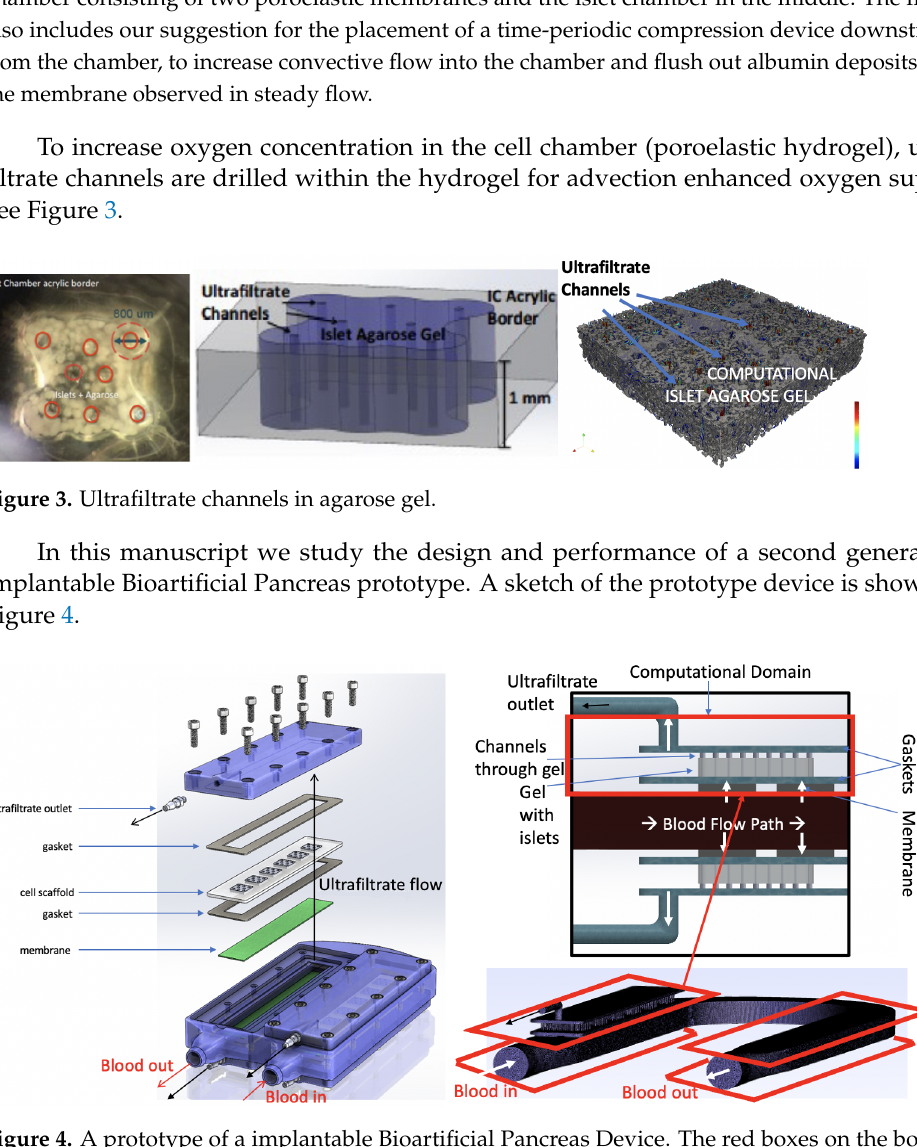
Figure 4. A prototype of a implantable Bioartificial Pancreas Device. The red boxes on the bottom right figure show the location where the four islet chambers are located. Only one of the four chambers is fully depicted in Figure 4 bottom right. A more detailed, magnified sketch of two such chambers is shown on the top figure on the right. The top chamber in the red rectangle shows the computational